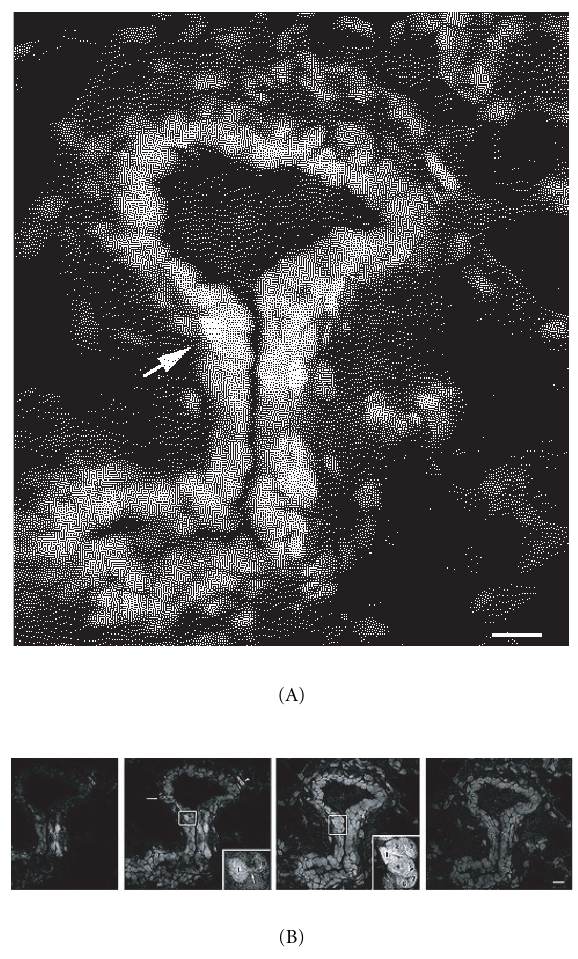
Figure 2: Confocal 3D microscopic image of bright TRITC labeled- retaining cells in 5 week-old FVB/N TEB. (A) 3D microscopic image of bright TRITC labeled-retaining cells. Note the location of bright LRCsandaTUs(arrow).(B)Lasersectionsrepresentenfaceviewsof serial sections that were recorded at 0 . 7 µ m intervals. Three dimen- sionalimageandopticalserialsectionsweregeneratedandprocessed according to materials and methods. Scale bars in (A), (B) 260 µ